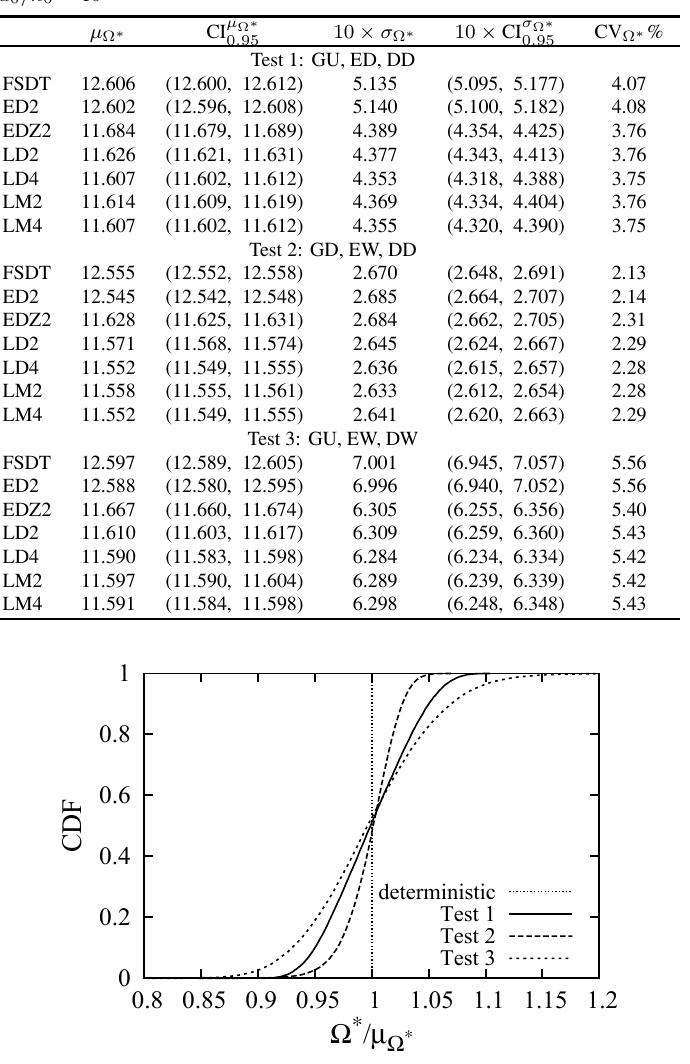
Ω ∗ statistic estimators in the case of the symmetric laminate, second material and a